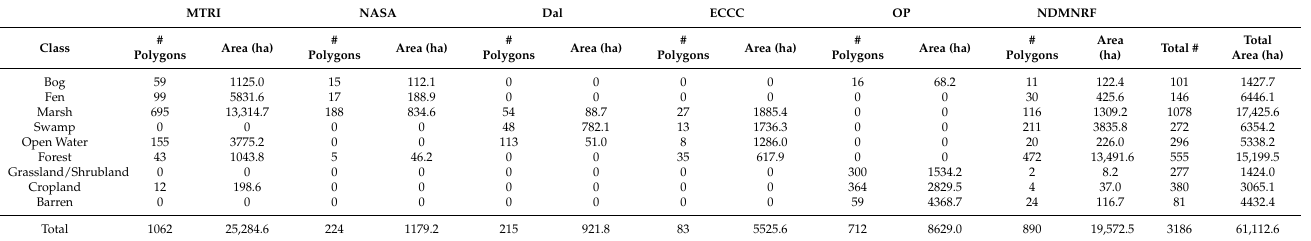
Figure 1. The study area (the Great Lakes basin and five subbasins of Lake Superior, Lake Huron, Lake Ontario, Lake Erie, and Lake Michigan) and the distribution of field data. The red box shows the location of the study area. Table 1. The statistics of the preprocessed field samples (polygons) received from different